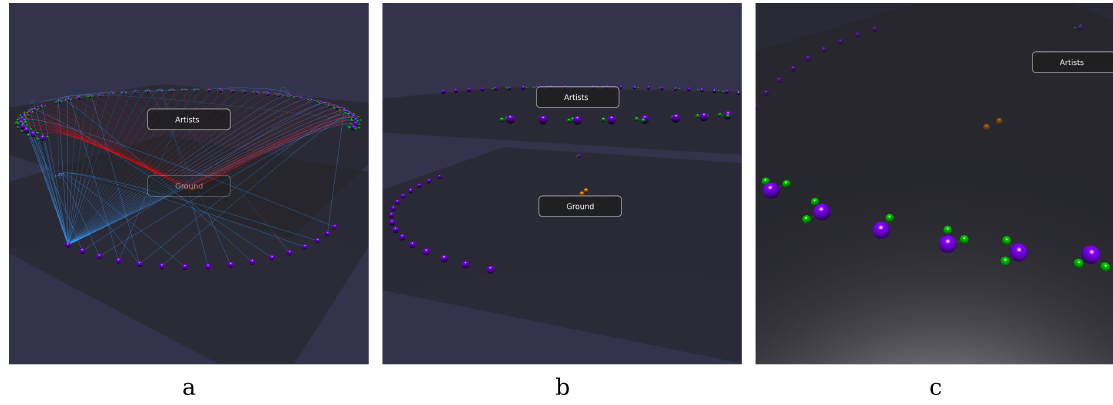
Figure 13. Use Case #2, Question 3: A semantic plane hosting artists is created on top of the ground plane ( a ). Unnecessary edges are hidden and the remaining green spheres refer to the dbo:deathDate property ( b ). Having more than one of these spheres means that the related artist has more than one death date ( c